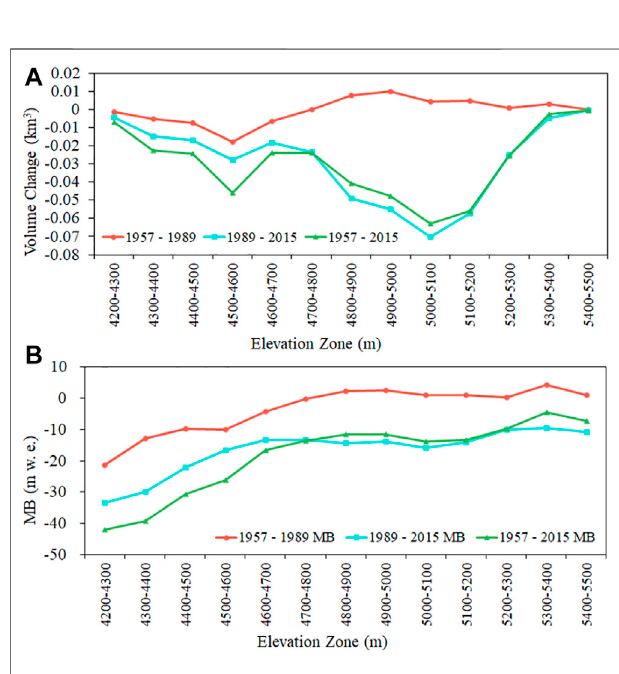
FIGURE 3 | Changes of volume and MB of LHG12 in elevation zone. (A) Volume change in elevation zone. (B) MB change in elevation zone.